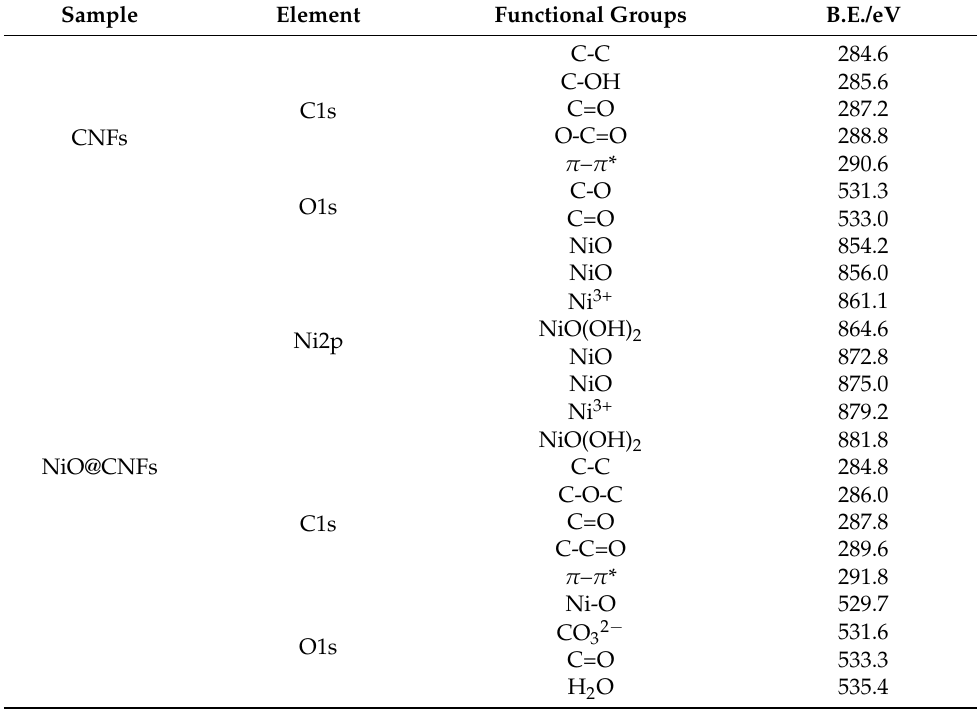
Table 1. XPS data obtained for the CNFs and NiO@CNFs samples.